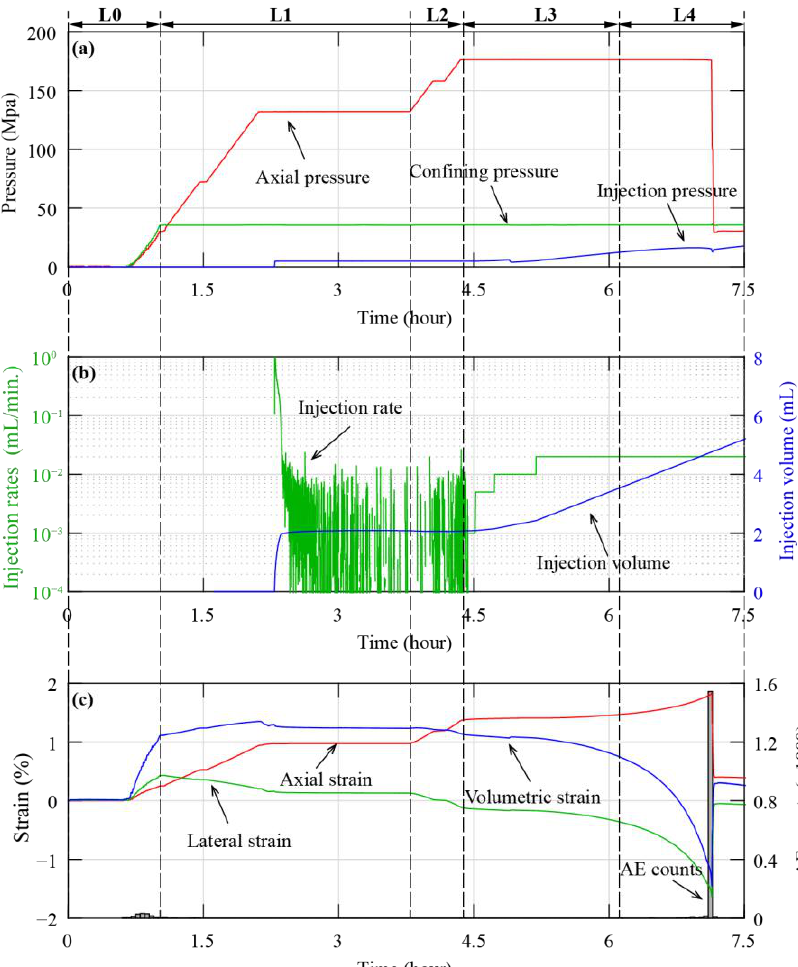
Figure 3. The loading history of the sample. The temporal variations of ( a ) stress; ( b ) water injection rate and volume; ( c ) strain and acoustic emission count. The experiment can be roughly divided into four stages: hydrostatic loading stage (L0), water-saturation stage (L1), axial loading stage (L2), hydraulic fracturing stage (L3), and rock fracture stage (L4). The black dotted line marks the demarcation points for each stage.